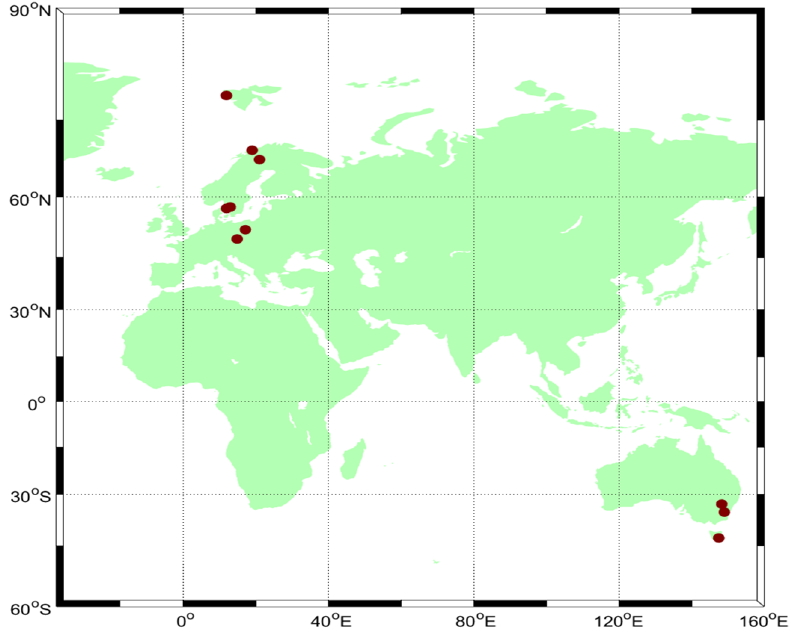
Figure 1. Geographical distribution of collected stations in the experiment. Table 1. Information of utilized BDS stations in the experiment.